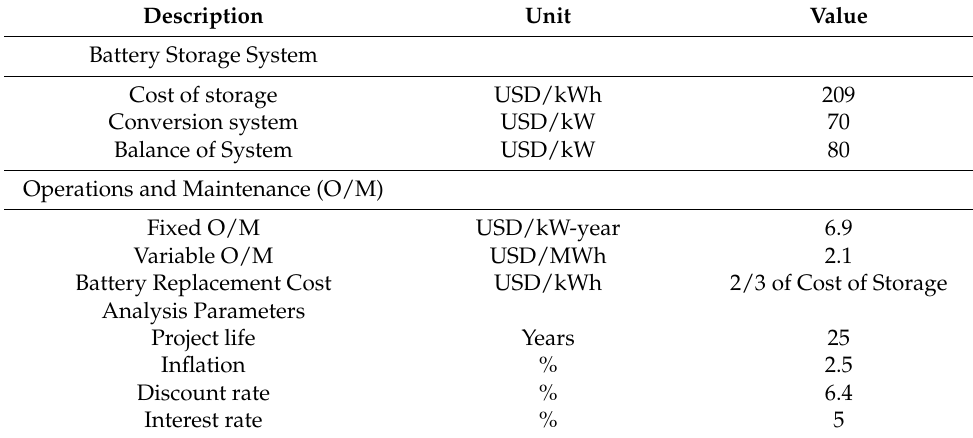
Table 9. Economic parameters for battery storage. Adapted from